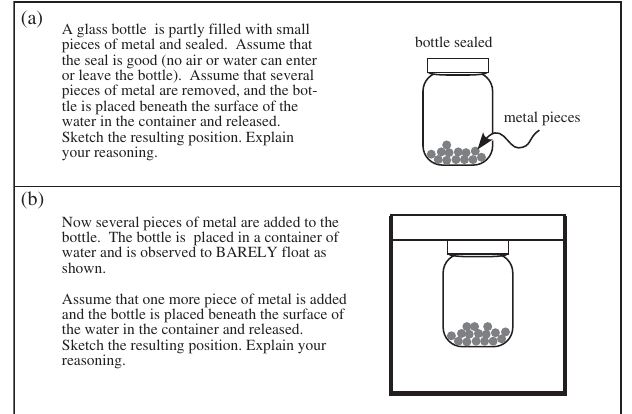
FIG. 3. The Shot problem. Panel (a) gives the initial setup and a preliminary question. Panel (b) is the part referred to in the text and data tables. This problem is given on an ungraded quiz in Phys/Chem 102 and a comparison course after instruction on density but before instruction on sinking and floating. This task is also now used as an instructional activity.